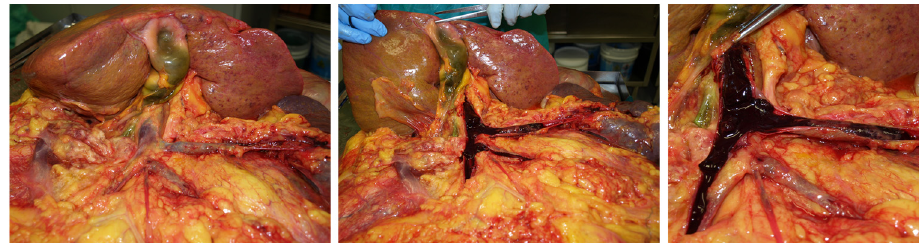
Figure 5. Autopsy investigation on case no. 3. Findings of massive thrombosis of the portal vein.